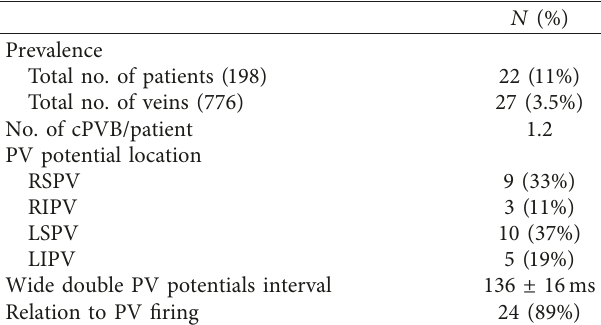
Table 1: Characteristics of